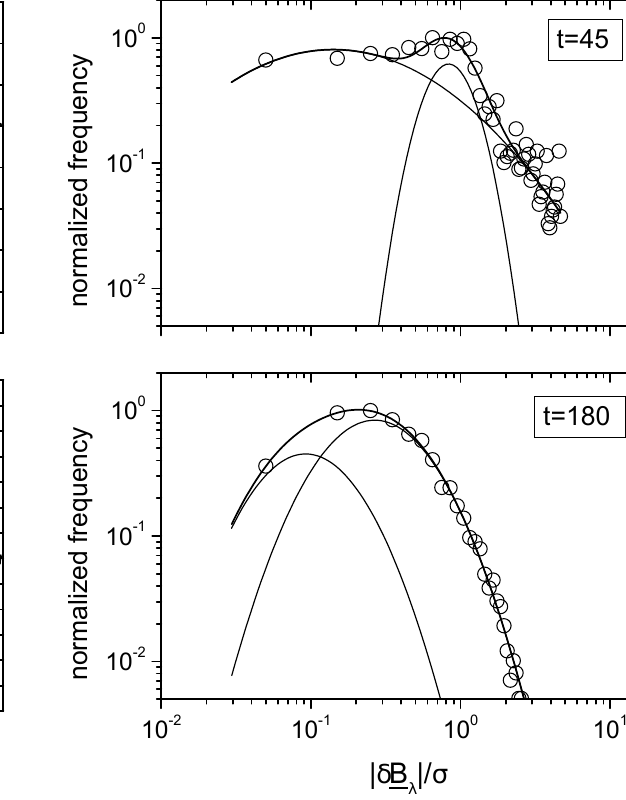
Fig. 19. Normalized vector displacements and normalized vector intensity versus position in the simulation box are shown in the same format as Fig. 18 for the results of the numerical simulations at time t = t 2 = 180 τ A . A difference with the previous figure, vec- tor displacements (top panel) appear to be more structured in space and some sort of correlation with the field intensity (bottom panel) can be recognized. This behaviour is qualitatively similar to that observed in fast solar wind at 0.9AU (Fig. 7).